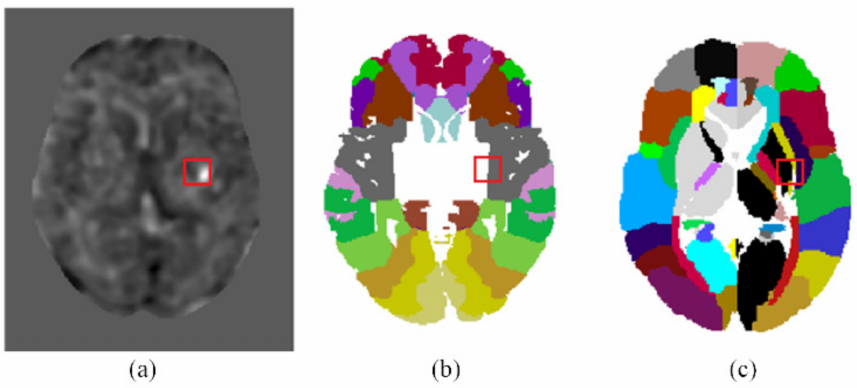
Figure 5. Mapping the detected infarcted patches onto the Brodmann areas and EVE atlas template. ( a ) The location of an infarcted patch detected by the proposed CNN on the t-score map. ( b ) The location of the infarcted patch is mapped onto the Brodmann areas. ( c ) The location of the infarcted patch is mapped onto the EVE atlas